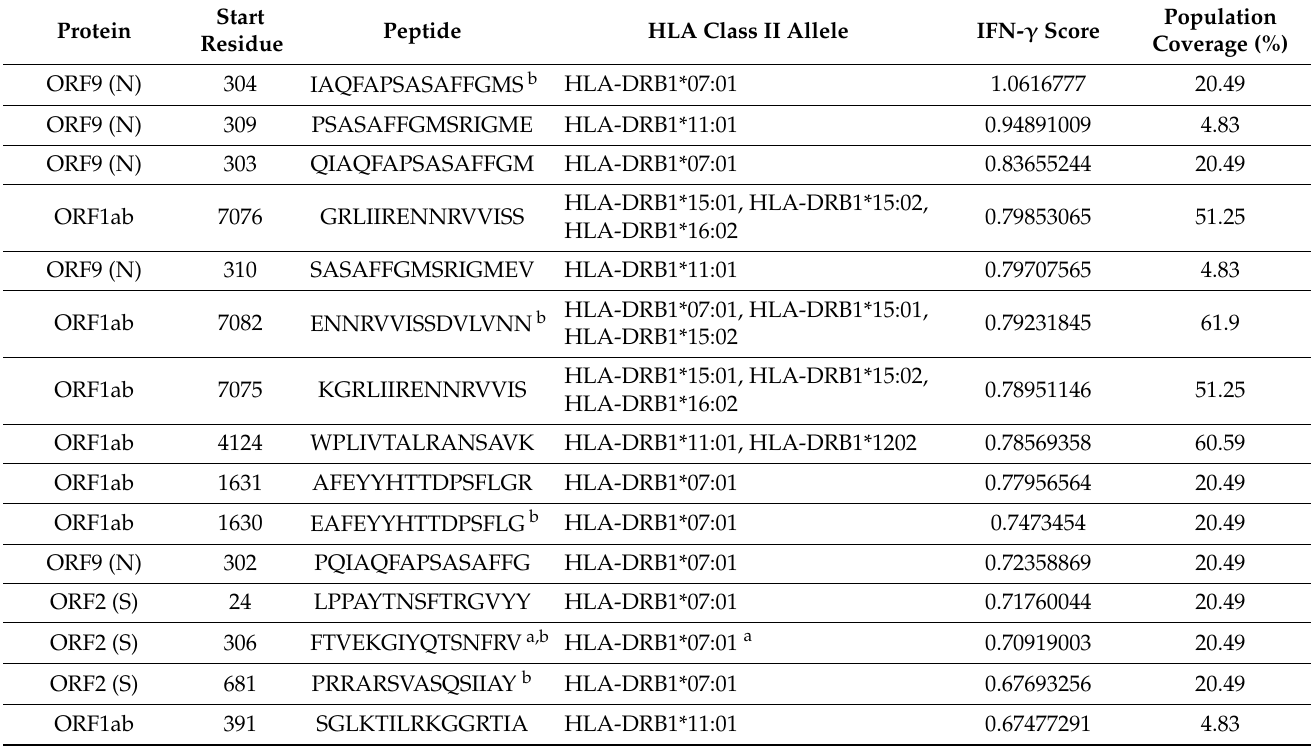
Table 4. Top 15 of 15-mer HTL epitopes with highest IFN- γ score from different SARS-CoV-2 proteins with %Rank less than